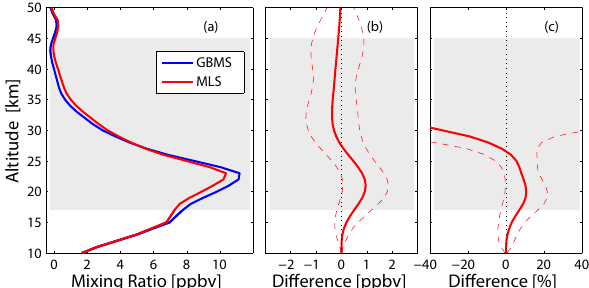
Fig. 6. Same as in Fig. 3, but for the HNO 3 intercomparison. A total of 43 coincidences was